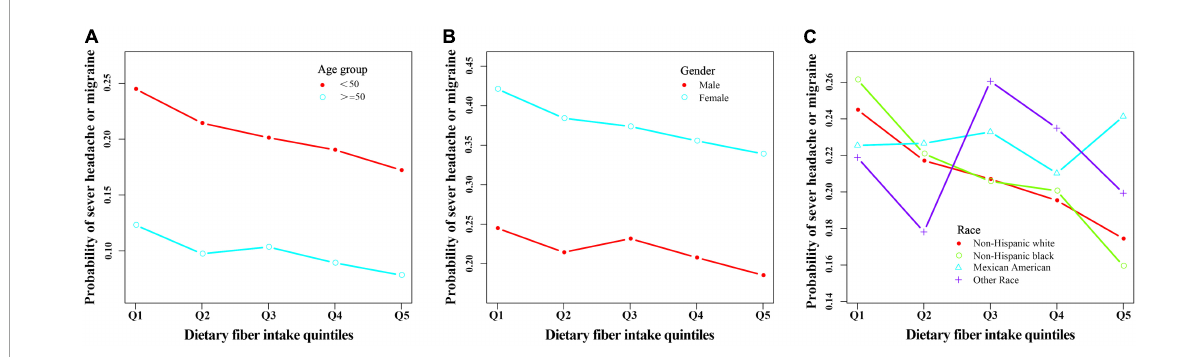
FIGURE3 The relationship between headache or migraine with dietary fiber quintiles stratified by age (A) , gender (B) , and race (C) after adjusting related covariates in this study.